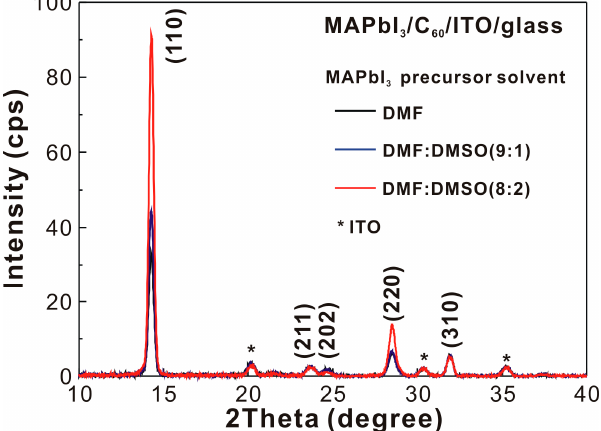
Figure 4. X-ray diffraction patterns of MAPbI 3 /C 60 /ITO/glass samples. Table 2. Structural, optical, and excitonic properties of MAPbI 3 thin films. PVH: peak-to-valley height;